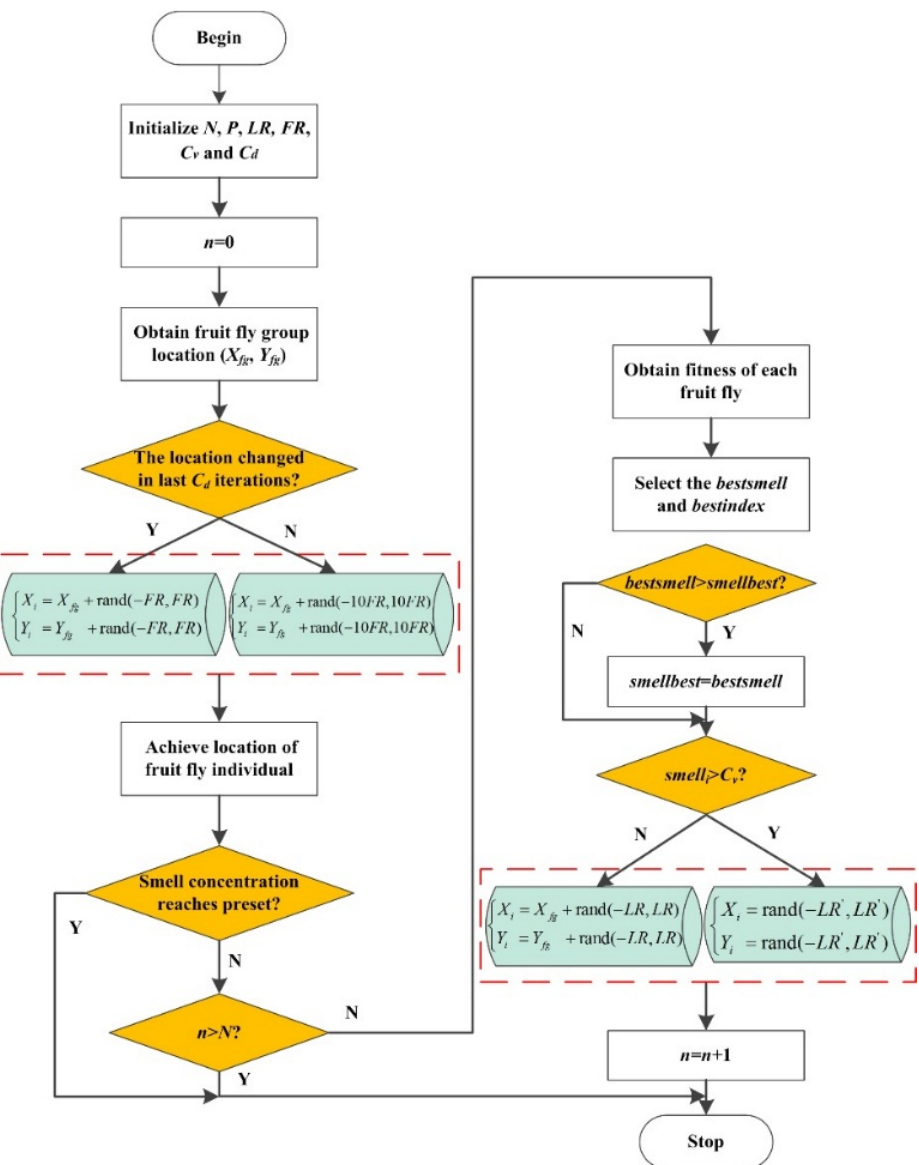
Figure 2. Flowchart of the improved fruit fly optimization algorithm (IFOA).